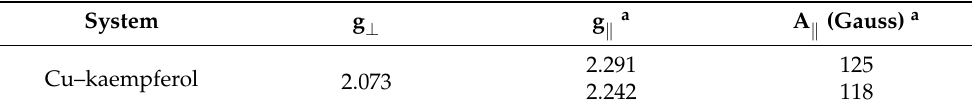
Figure 2. EPR spectrum of in DMSO solution at 110 K. Concentration of Cu was 1 mM. Table 1. EPR data of Cu–kaempferol complex (1:1) in DMSO at 100 K. Table 1. EPR data of Cu–kaempferol complex (1:1) in DMSO at 100 K. System g  g  a A  (Gauss) a System Cu–kaempferol